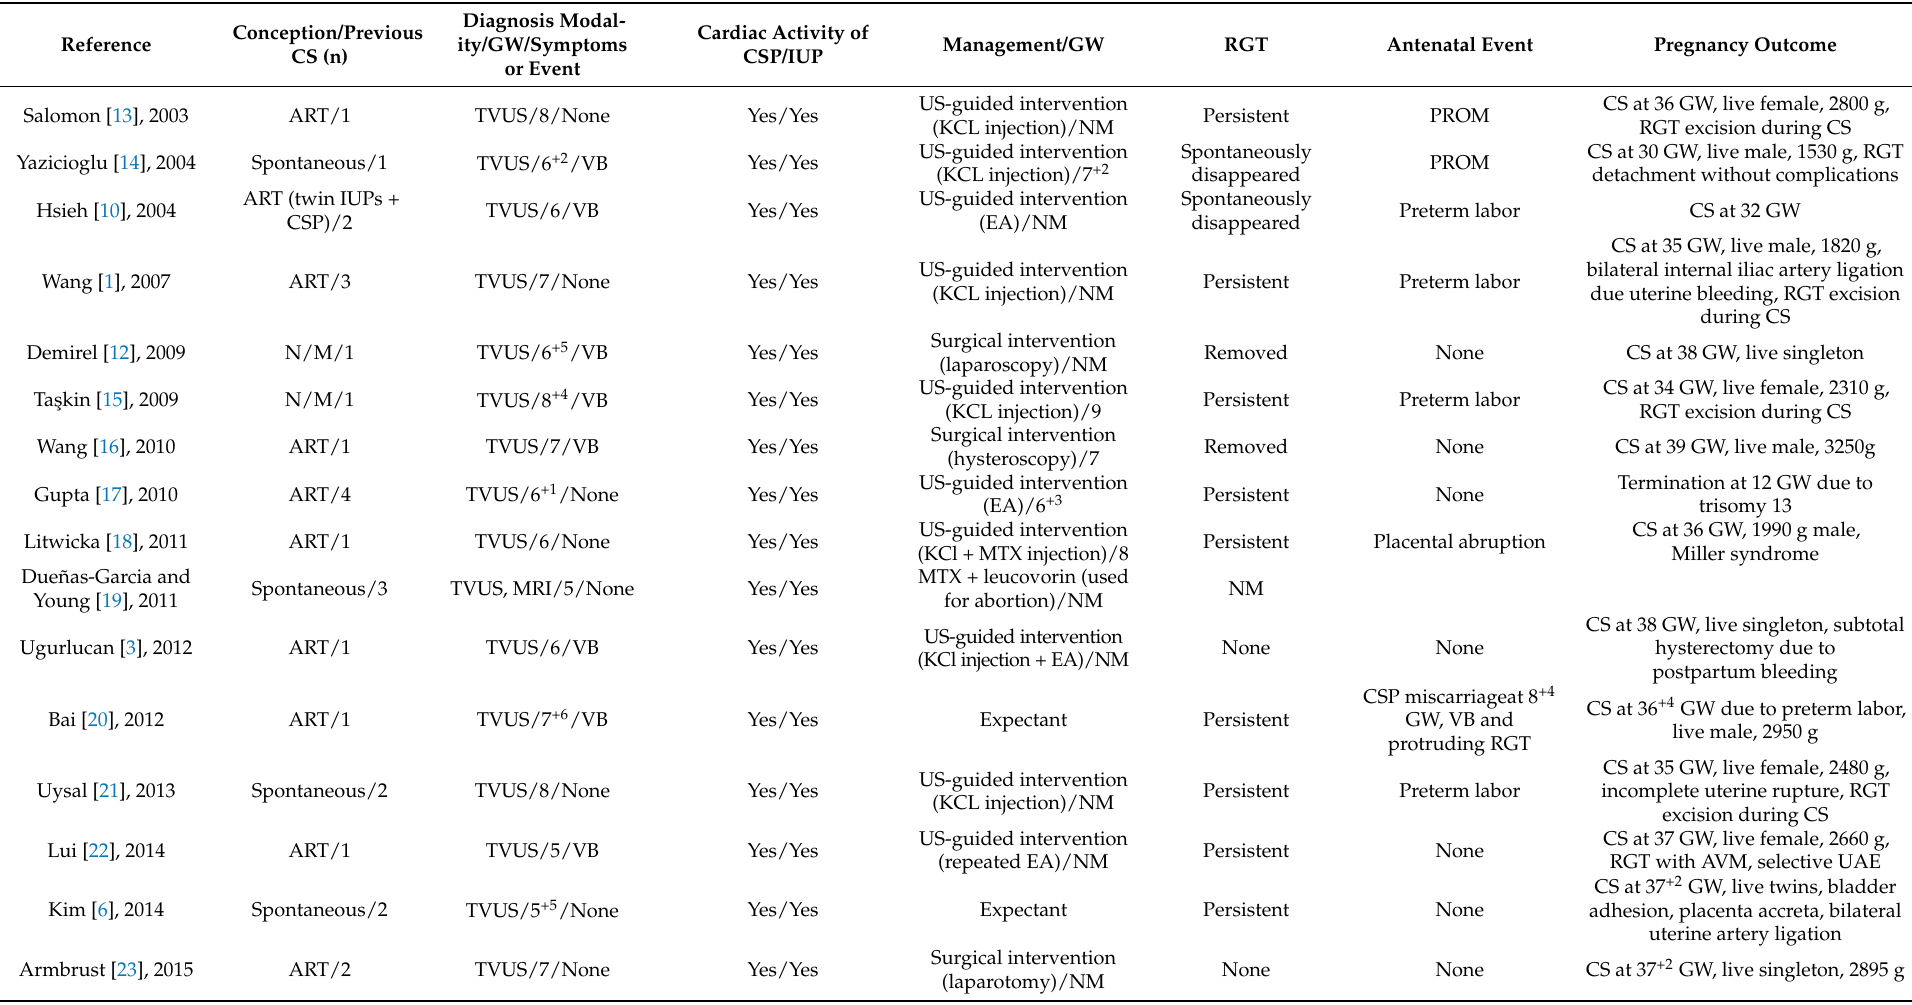
Table 1. Literature review of heterotopic cesarean scar